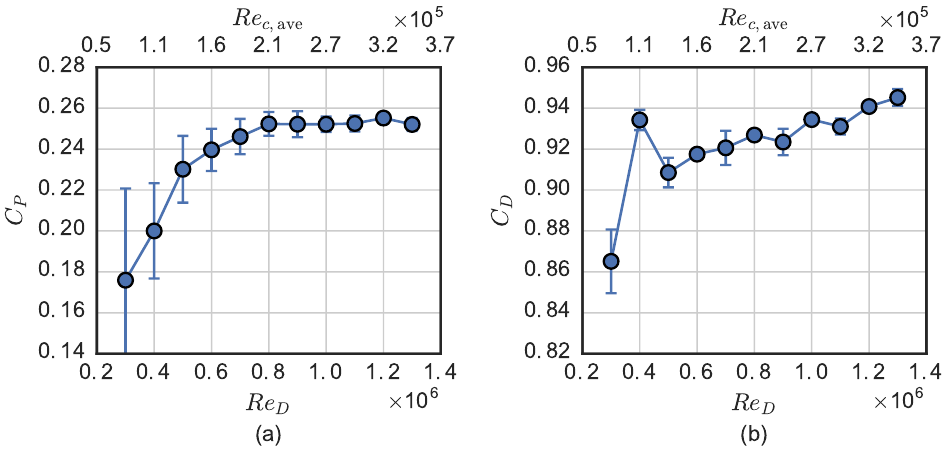
Figure 6. UNH-RVAT measured mean power ( a ) and drag ( b ) coefficients at λ = 1.9 plotted versus the Reynolds number. Error bars indicate expanded uncertainty estimates for 95% confidence, which for C P is dominated by systematic error estimates from the torque transducer operating at the lower end of its measurement